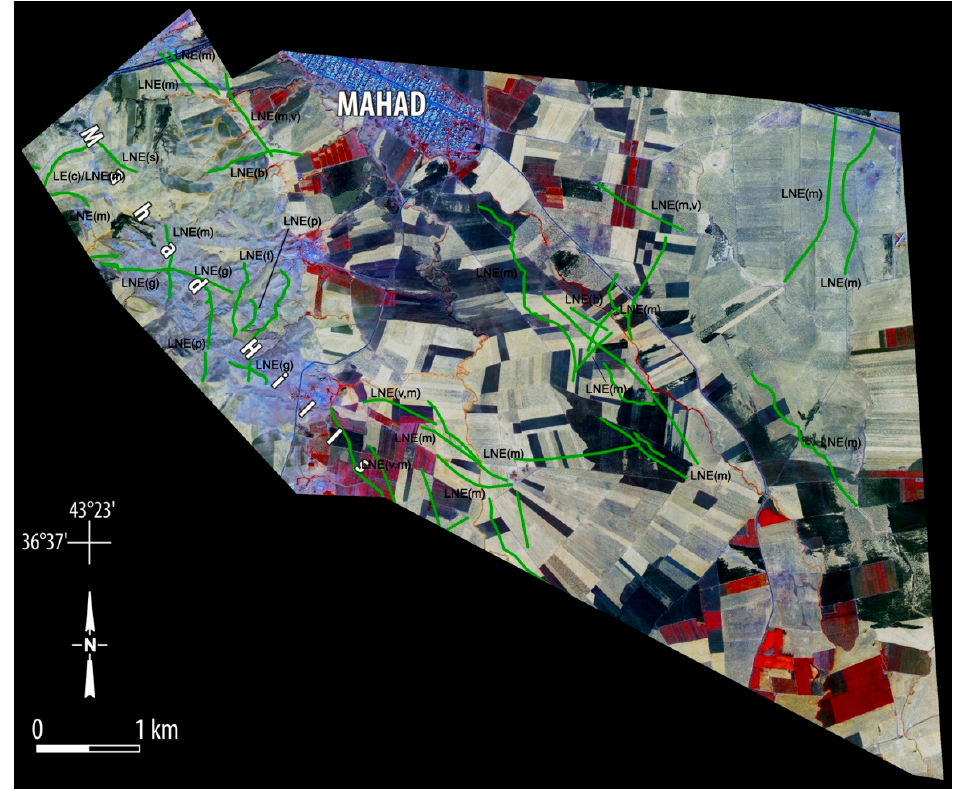
Figure 8. Detected linear features that required field verifications. Abbreviations refer to the most important photointerpretation features for a given indicator, presented in Table 2. Background image WV2, FCC 158 IHS (ID10300100388F8C00). WorldView ‐ 2 © 2014 DigitalGlobe, Inc.,